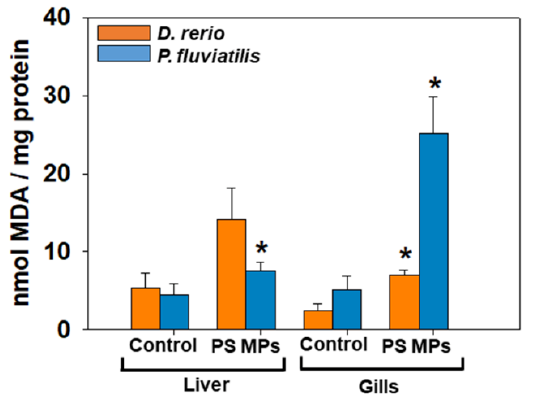
Figure 3. Lipid peroxidation was expressed as MDA concentrations (mean ± SD nmol mg − 1 protein), in liver and gills of Danio rerio ( n = 3 pools of 10 individuals) and Perca fluviatilis ( n = 6). Mann– Whitney U test was employed to test for significance at p < 0.05 between all experimental groups. * denotes significant differences ( p < 0.05) compared to the control group ( n = 3 pools of 10 individuals and n = 6 for D. rerio and P. fluviatilis respectively).